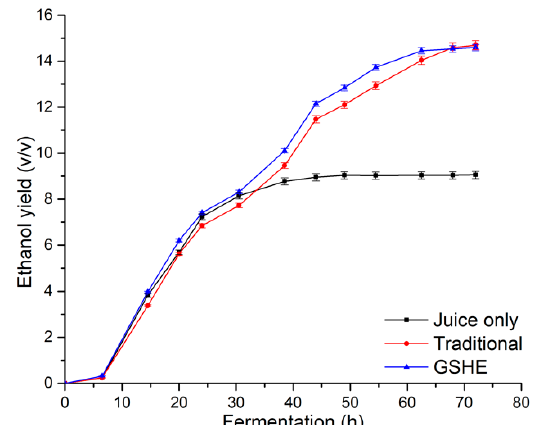
Figure 6. Ethanol fermentation yield of juice only and juice plus sorghum grain flour with (Traditional) and without (granular starch hydrolyzing enzymes (GSHE)) hydrolysis.